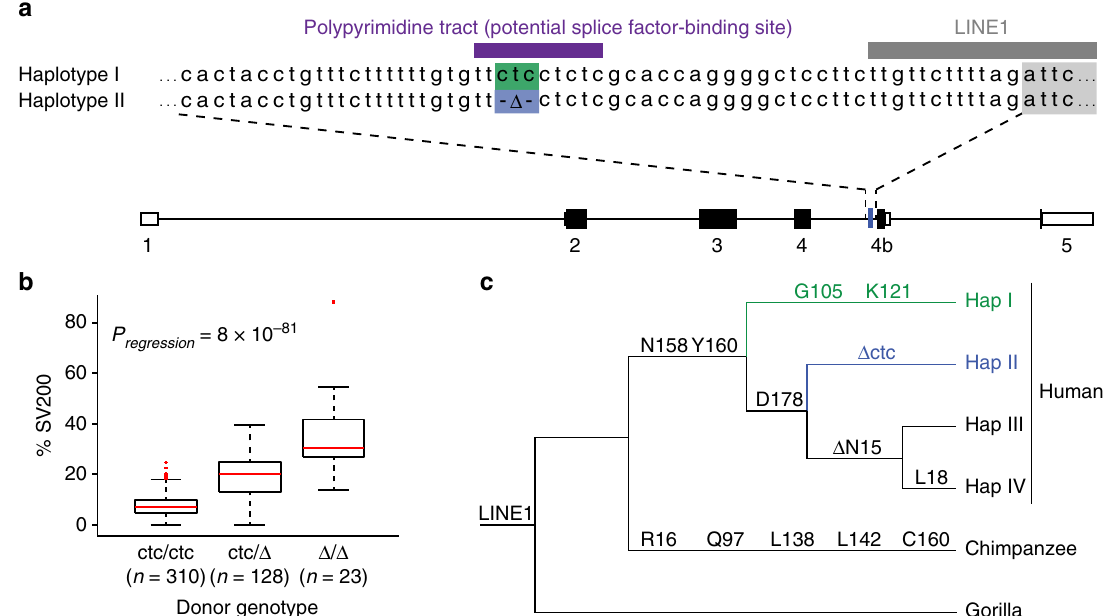
Fig. 3 An intronic Δ ctc associates with A3H haplotype II and SV200 expression. a A3H intron 4 alignment with ctc in haplotype I (green) and Δ ctc in haplotype II (blue) (rs149229175). Additional relevant cis elements include a polypyrimidine tract (purple) and a LINE1 (gray). b Box and Whisker plot showing the percentage of SV200 transcripts in cells with the indicated A3H intron 4 genotypes. In this plot, boxes, middle lines and broken lines display interquartile ranges (IQRs), medians, and 1.5 IQR, respectively. Outliers (>1.5 IQR) are shown and the p value is obtained using one-way ANOVA. c A schematic showing the phylogenetic relationships between the major human A3H haplotypes (frequencies > 1%) and selected non-human primate homologs. The LINE1 insertion, coding changes, and the haplotype II-speci fi c ctc deletion are indicated in relevant divergence intervals (not to a speci fi